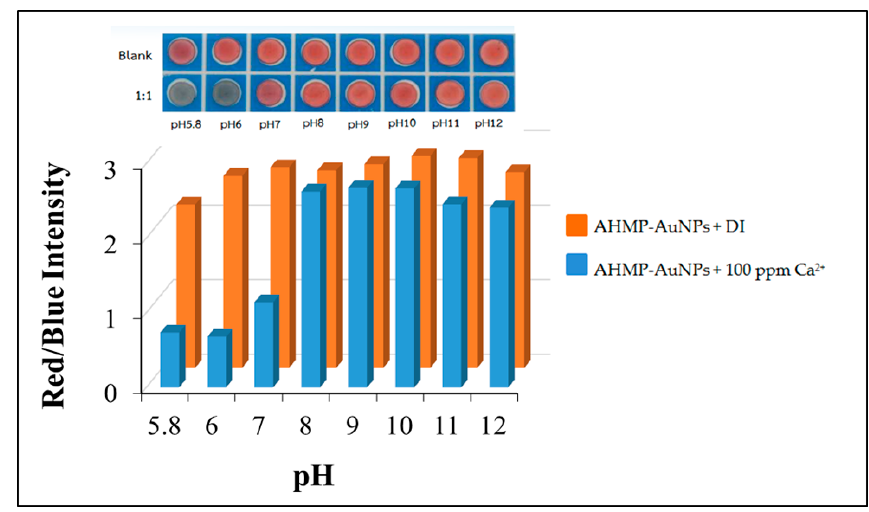
Figure 4. The influence of pH over the range 5.8–12 on the aggregation process of the AHMP-AuNPs and 100 ppm Ca 2+ , other conditions are the same as in Figure 3.